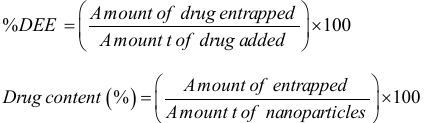
Fig. 4: schematic of cisplatin-encapsulated Fe